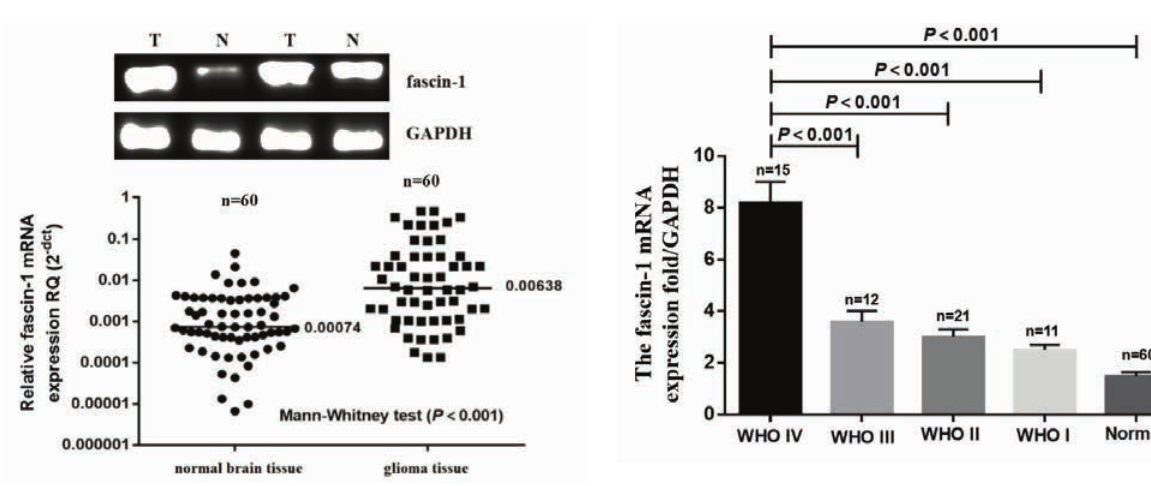
Figure 3: The relationship of fascin-1 mRNA expression level and pathological grades of patients with glioma. ANOVA was the statis- tical test